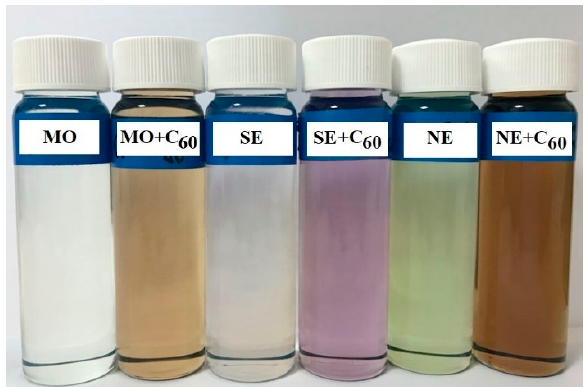
Figure 2. Comparison of prepared samples of fullerene C 60 -based nanofluids with samples of base liquids; from the left: MO—mineral oil, MO + C 60 —mineral oil doped with fullerene C 60 , SE—synthetic ester, SE + C 60 —synthetic ester doped with fullerene C 60 , NE—natural ester, NE + C 60 —natural ester doped with fullerene C 60 .